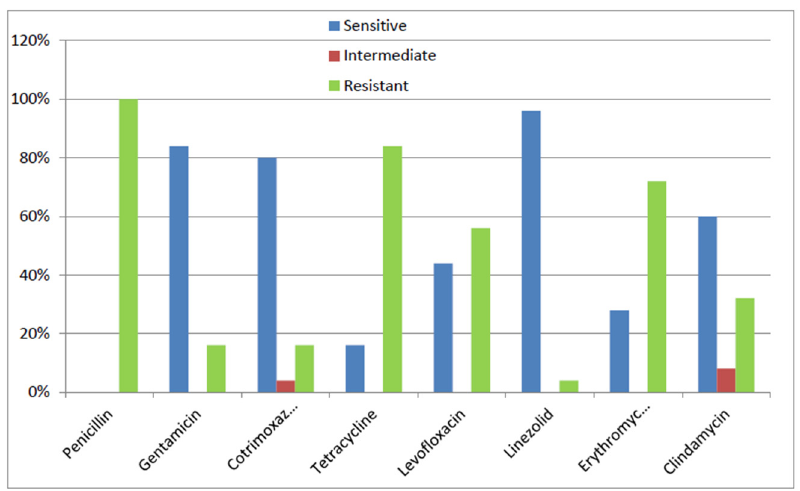
Figure 2. Antimicrobial susceptibility pattern of MSSA isolates.